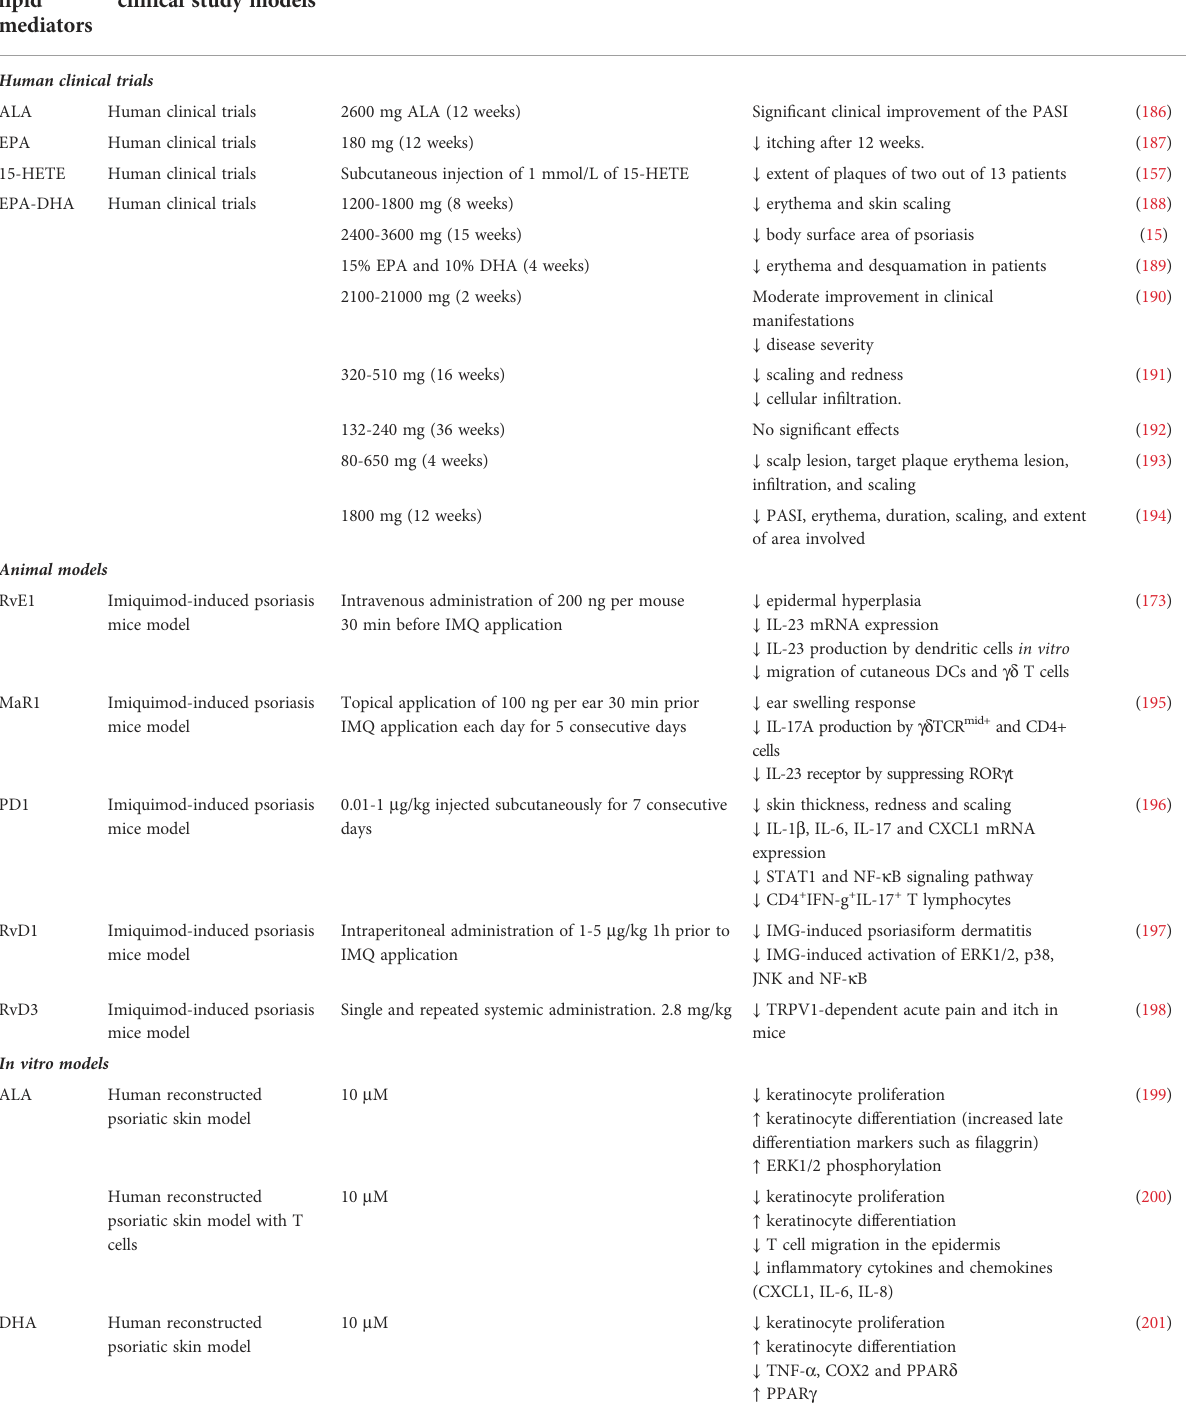
TABLE 2 Summary of studies examining the effect of PUFA interventions in psoriasis. PUFAs or